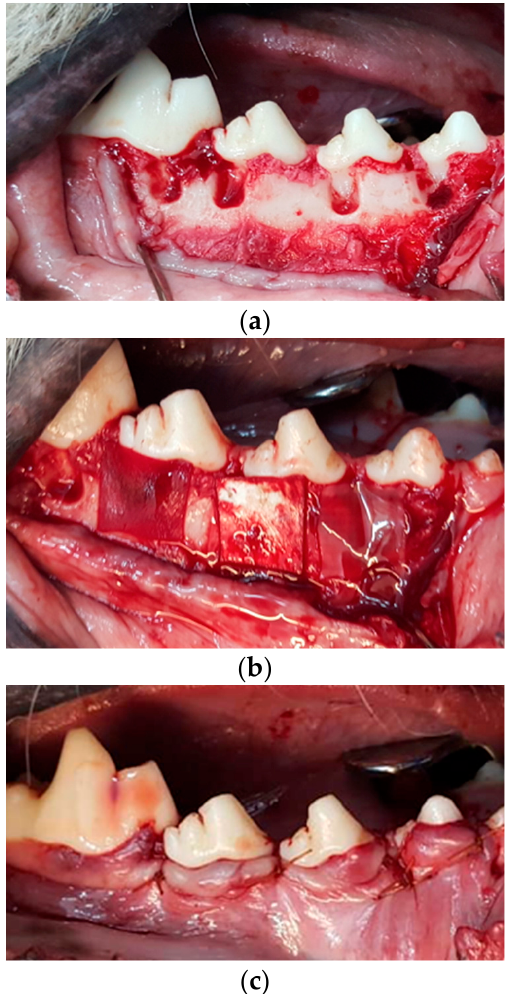
Figure 3. Surgical procedure the preparation of surgically induced dehiscent defects on maxillary premolar teeth. ( a ) The defects (5 × 5 mm below the CEJ) were formed on the buccal side of the distal root of the mandibular premolars and mesial root of first molar teeth, ( b ) Placement of the membranes on defect sites, ( c ) Flap replacement and suturing.